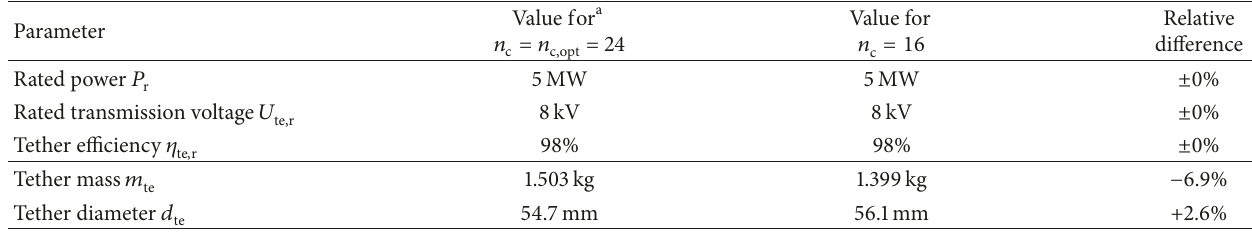
Table 1: Parameters of the two tether designs in Figure